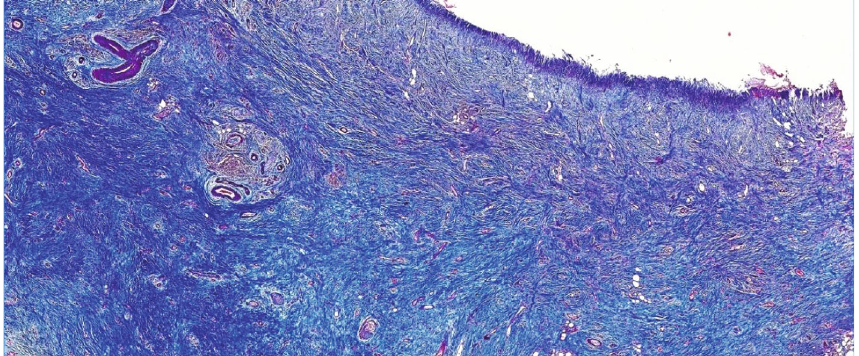
Figure 3: Trichrome stain (Masson); 2x: pancreas with extensive fi